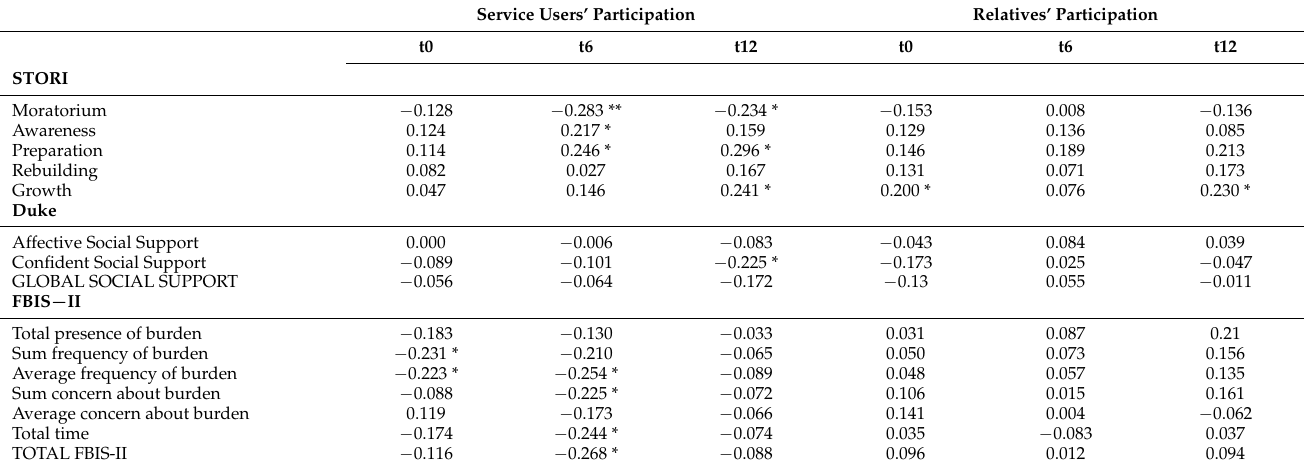
Table 4. Pearson correlations between service users’ and relatives’ participation and scores at all time